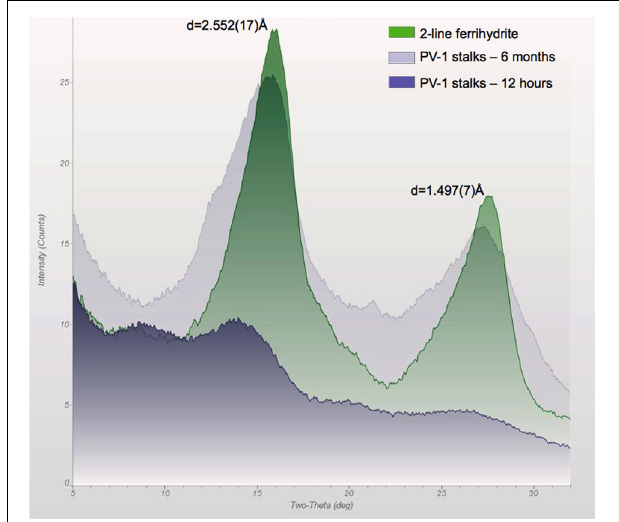
FIGURE 10 | X-ray diffraction pattern of the stalks of PV-1 compared to synthetic 2LF, showing the development of slightly more crystallized iron oxyhydroxide with time. At 12h, the sample was growing at log-phase and the biofilm had an off-white/light yellow color. At 6 months, the sample was reddish. At 3 days of growth, the sample had an orange/reddish color which generated a similar spectrum as the 12h sample (data not shown). The d -spacing values correspond to 2LF for this synthetic